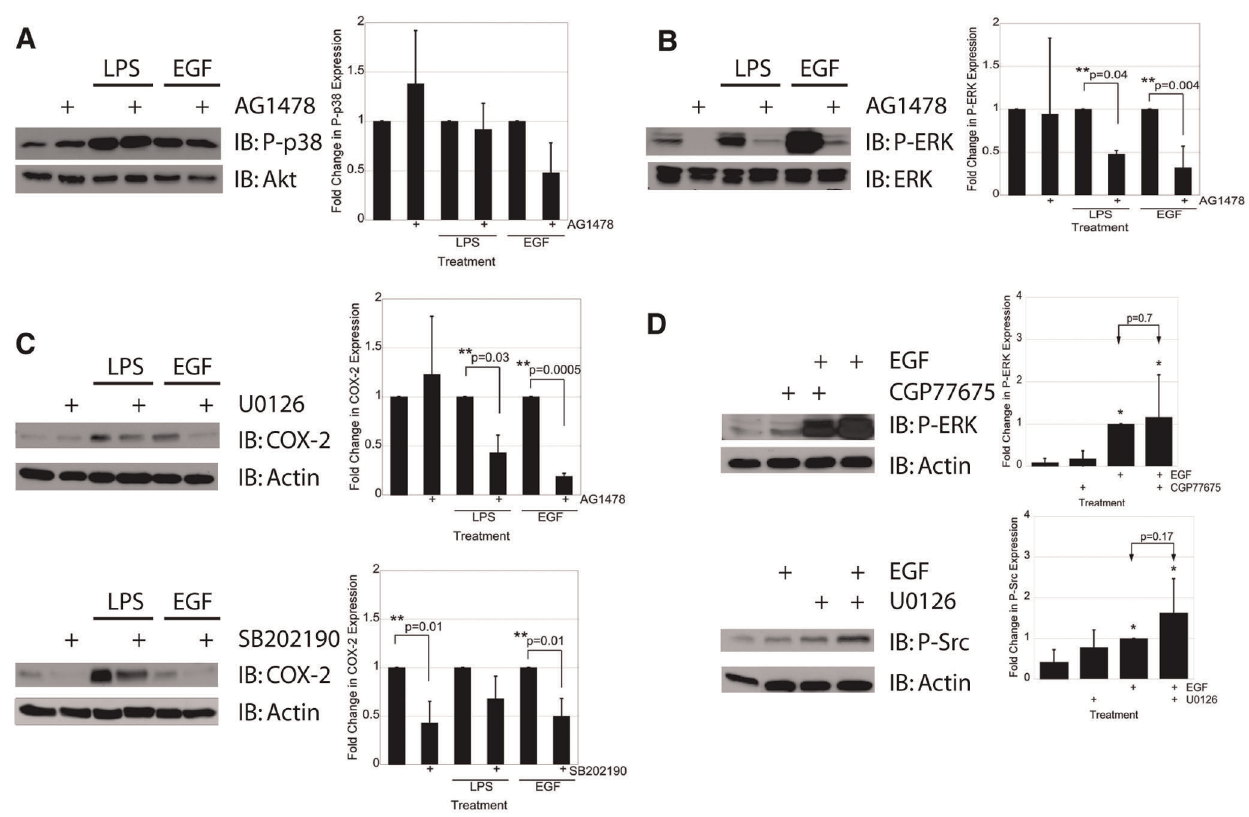
Figure 3. ERK and Src, but not p38, are required for EGFR-mediated induction of COX-2. A) IEC-6 cells were treated with LPS (2 m g/mL) for 15 minutes or with EGF (10 ng/mL) for 5 minutes in the presence or absence of the EGFR kinase inhibitor AG1478 (1 m M). Western blot analysis of P- p38 MAPK showed no significant difference in p38 activation in the presence of EGFR inhibition. B) IEC-6 cells stimulated with LPS (2 m g/mL) for 15 minutes or with EGF (10 ng/mL) for 5 minutes in the presence or absence of AG1478 (1 m M). C) IEC-6 cells were treated with LPS (2 m g/mL) for 24 hours or with EGF (10 ng/mL) for 5 minutes in the presence or absence of the ERK1/2 inhibitor U0126 (10 m M) or the p38 inhibitor SB202190 (10 m M) as shown, and COX-2 expression was determined using Western blot analysis. D) IEC-6 cells were treated with EGF (10 ng/mL) for 5 minutes in the presence or absence of the Src family kinase inhibitor CGP77675 (2 m M) and analyzed for P-ERK activation using Western blot analysis. Src inhibition had no effect on EGF-induced P-ERK (p=0.7). IEC-6 cells were also treated with EGF (10 ng/mL) for 5 minutes in the presence or absence of the ERK kinase inhibitor U1026 (10 m M) and analyzed for P-Src activation using Western blot analysis. ERK inhibition had no effect on EGF-induced P- Src activation (p=0.17). Single asterisks indicate significant differences from control. Double asterisks indicate significant differences between two bracketed conditions.